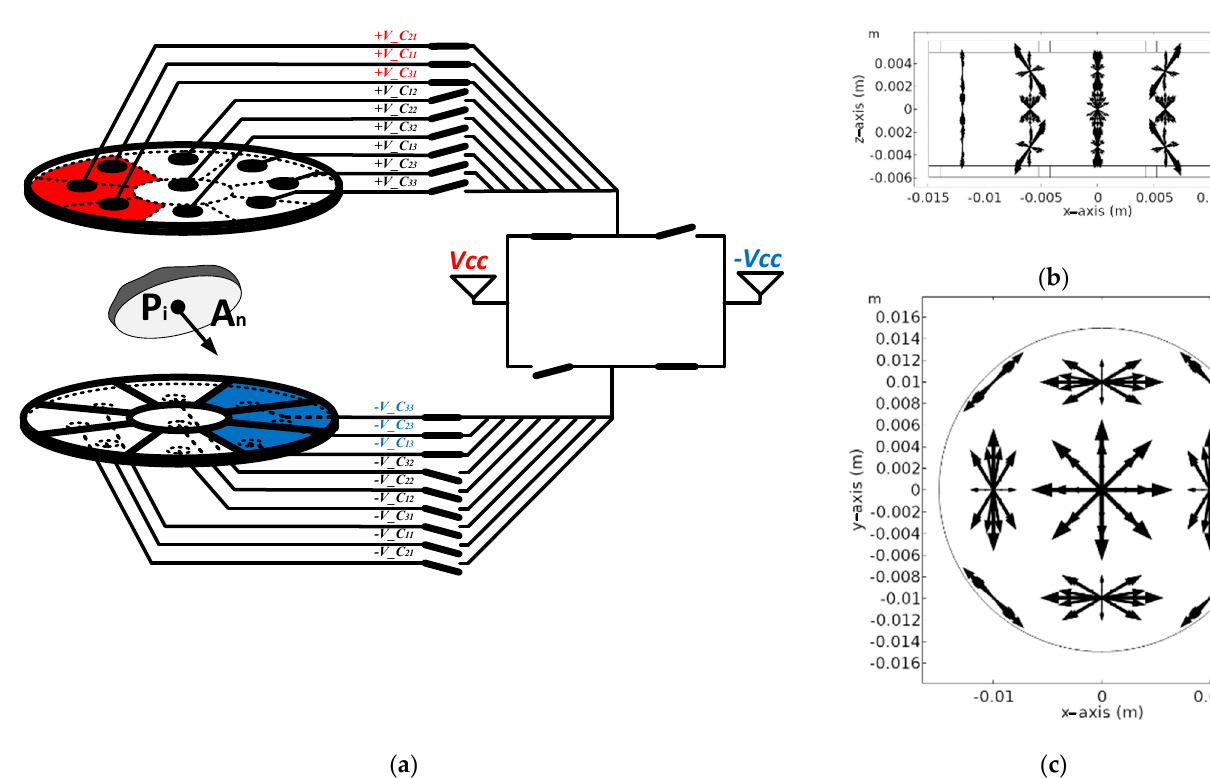
Figure 4. Schematic of the application of voltage in example setting: ( a ) Electric field vectors in the circular model applying 32 voltage settings; ( b ) in vertical slice (y = 0); ( c ) in horizontal slice (z = 0).